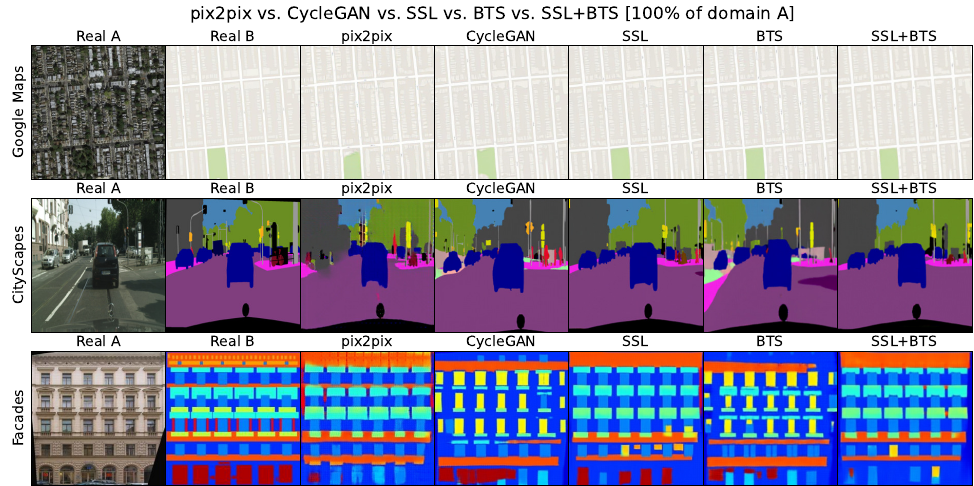
Figure 6. Visual examples of the proposed vs. baseline algorithm comparisons for 100% of the scarce domain data used: Real A (scarce domain) and Real B (target domain) correspond to image pair examples. Examples are given for Google Maps , CityScapes and Facade datasets. SSL denotes that only SSL on the control part of pared images is included in the training of CycleGAN, BTS denotes that only bootstrapping of the statistic of the A discriminator pool is included in the training, while SSL+BTS denotes that both SSL and BTS are